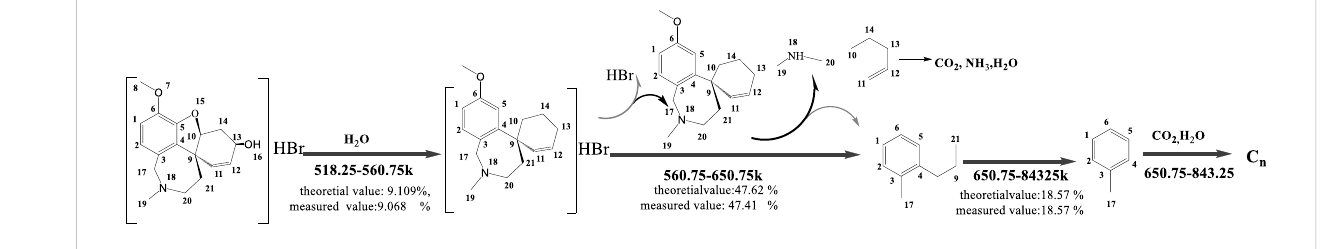
FIGURE 3 Thermal decomposition scheme of galanthamine hydrobromide.